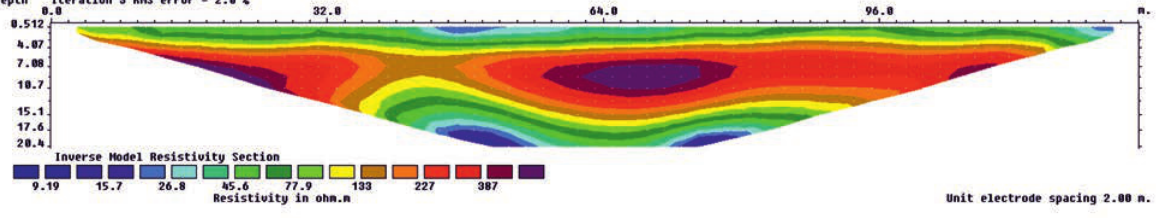
Figure 11. Eletric Resistivity Tomography performed on Osteria Necropolis